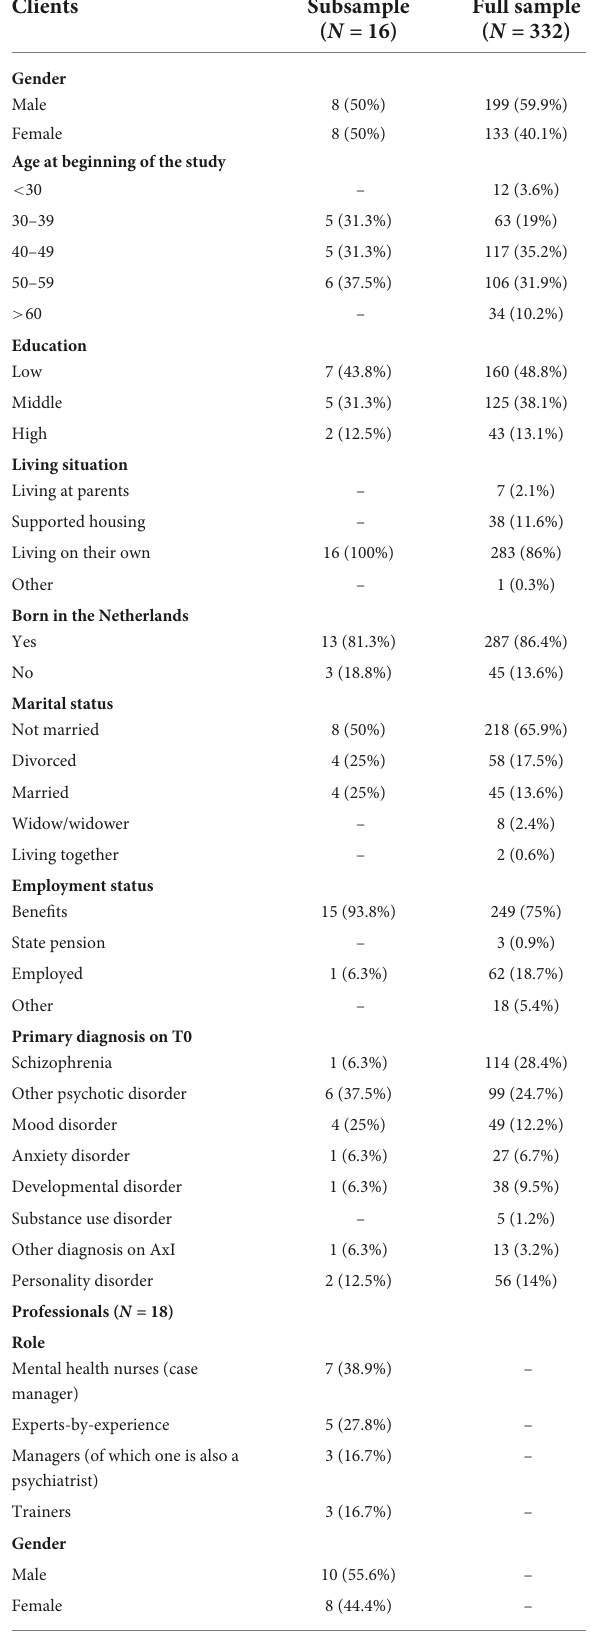
TABLE 3 Characteristics of the interviewees at